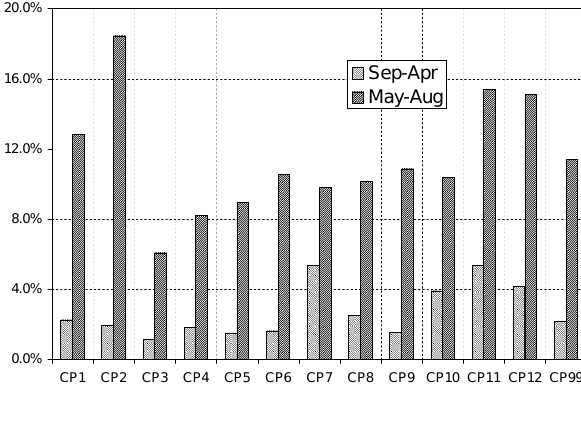
Fig. 4. Exceedance frequency of the 95 % and 99 % quantile for two seasons; quantiles and frequencies are calculated for all hours with R ≥ 0 . 1 mm Fig. 5. Trends in the frequency of anticyclonic (CP2, CP3, CP5 and CP8 – first line) and cyclonic CPs (CP7, CP10, CP11 and CP12 – second line) according to NCEP/NCAR